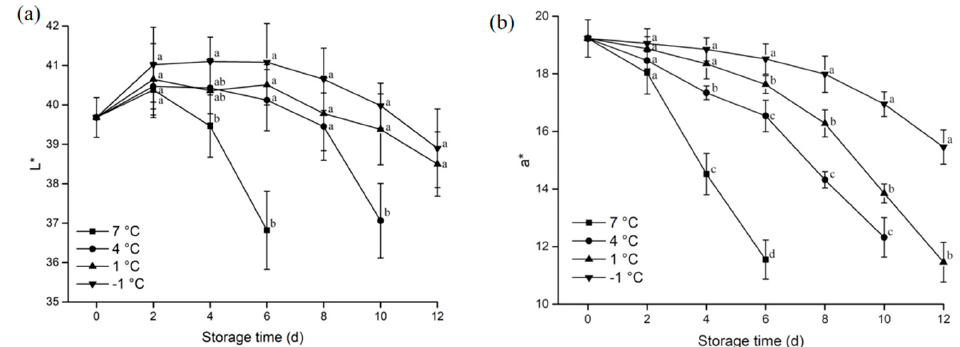
7 of 17 Figure 1. Effect of different storage temperatures on drip loss of pork. Different lowercase letters (a, b) indicate significant difference (p < 0.05) between each treatment on the same storage time . The drip loss of four groups of samples subjected to different treatments increased with the extension of the storage period. The drip loss was lower as the storage tempera- ture decreased. After the fourth day, the drip loss of the samples stored at 1 °C and − 1 °C was significantly lower compared with that of the samples stored chilled at 7 °C ( p < 0.05). The result was consistent with that of Lin et al. [23]. 3.1.2. Color The color changes of pork are the result of microbial contamination and the degree of myoglobin oxidation and will determine consumer acceptability of the stored meat [24]. As shown in Figure 2a, the brightness (L*) of the four groups of samples under dif-